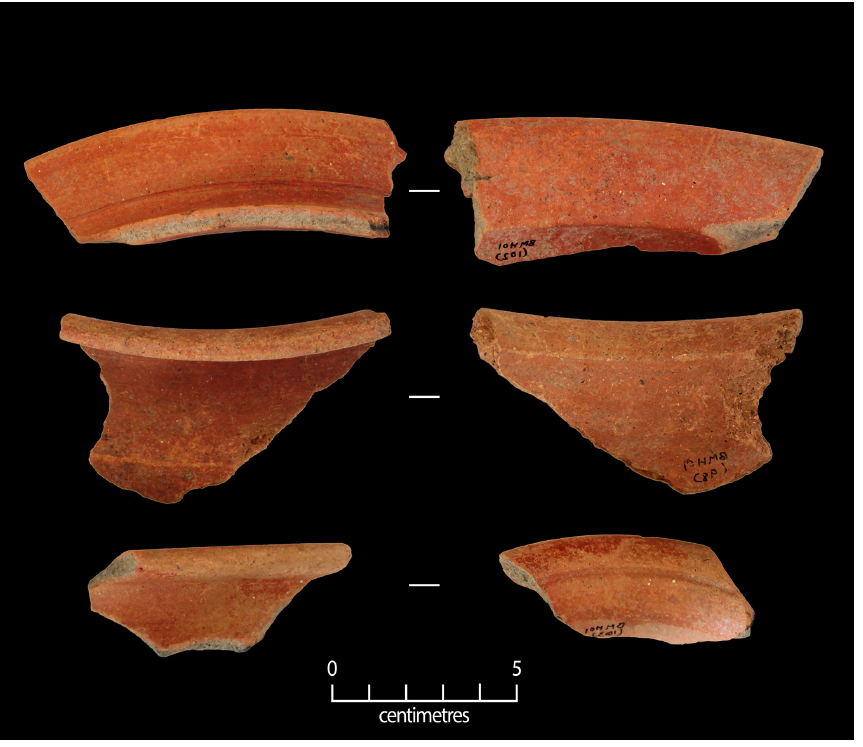
Figure 5: Examples of external and internal surfaces of Class 2 variant 1 rim